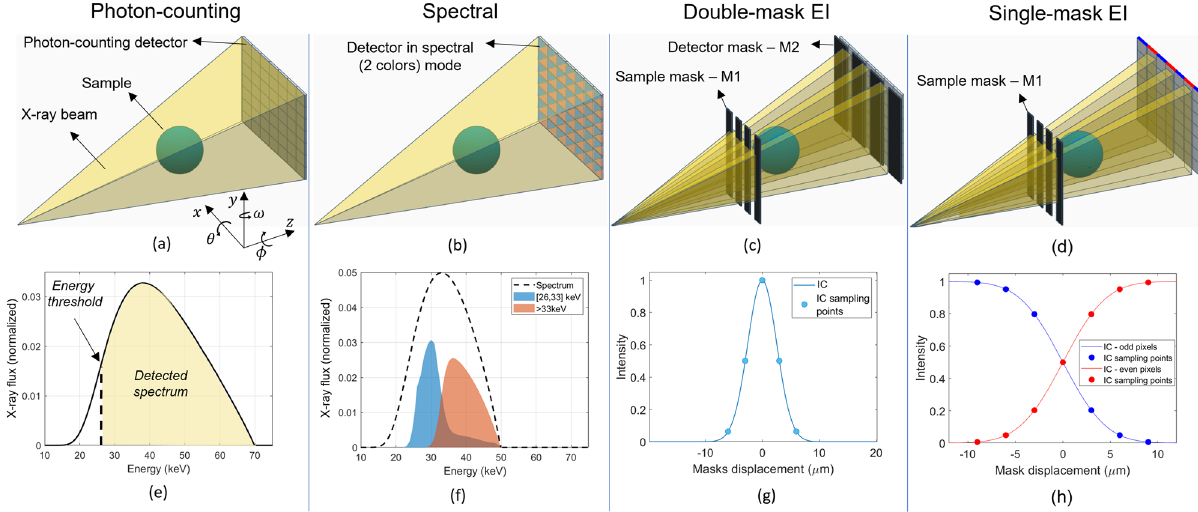
Figure 2. The four imaging modalities, namely photon-counting ( a ), spectral ( b ), single-mask EI ( c ), and double-mask EI ( d ). In ( e ) a typical X-ray spectrum used in photon-counting CT, in ( f ) the spectral response of the Pixirad-1/Pixie-III over the 2 selected energy bins optimized for the iodine K-edge (filled plots), expressed in counts per input photon per keV, along with the X-ray spectrum (dashed line). X-ray spectra are area normalized. In ( e ) and ( f ) the typical IC shapes for the single and double mask arrangements,